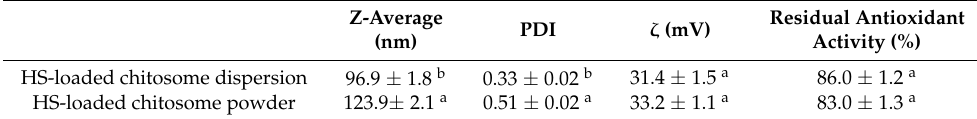
Table 4. Physicochemical properties of reconstituted hydrolysate-loaded γ -oryzanol-chitosomes.